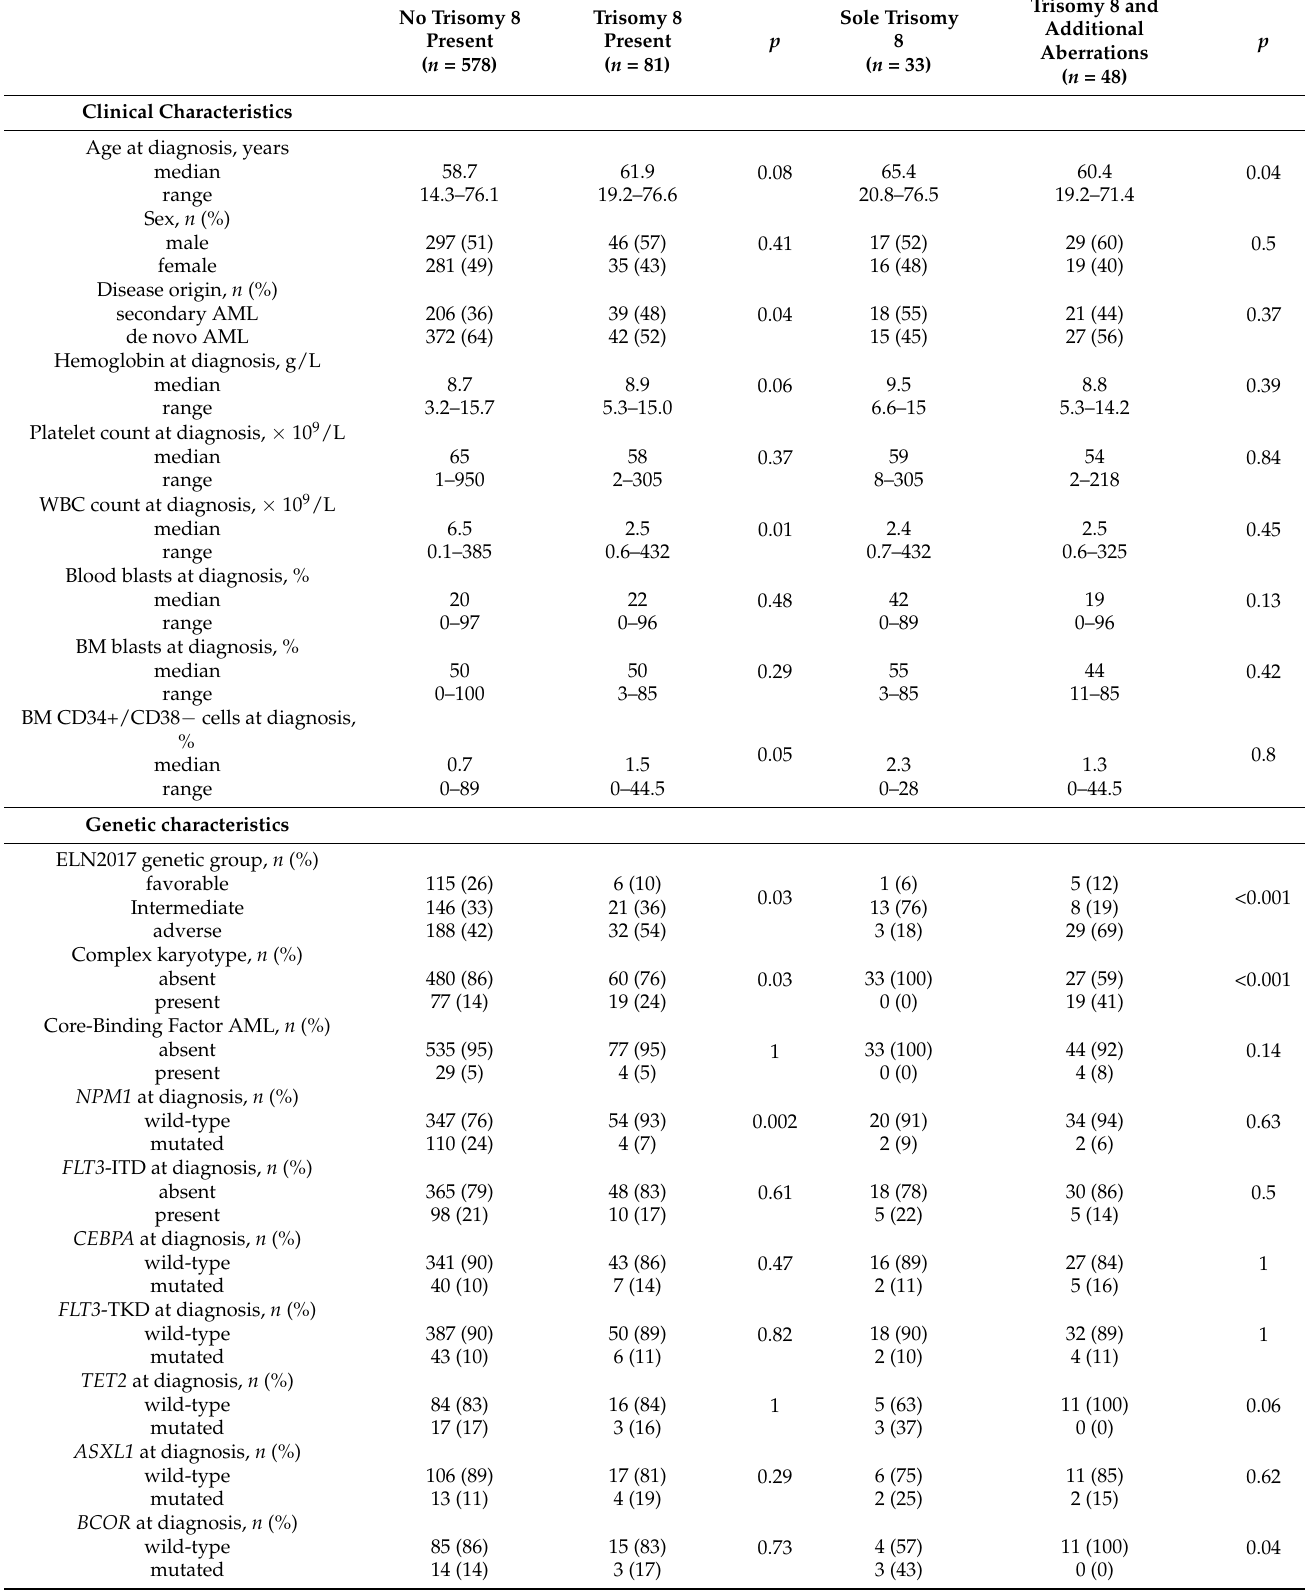
Table 1. Clinical and genetic characteristics of AML patients undergoing allogeneic HSCT according to the presence or absence of a trisomy 8 with or without additional cytogenetic aberrations ( n = 659). No Trisomy 8 Trisomy 8 Present ( n = 578)